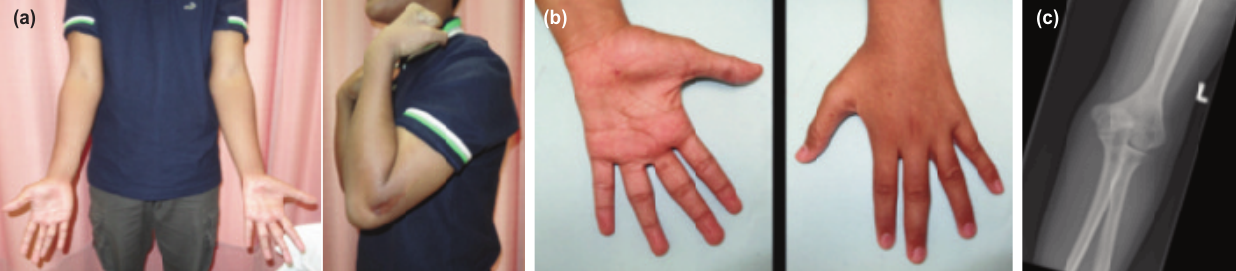
Clinical and radiological photographs four years after surgery. (a) Left elbow deformity corrected with full range of elbow Fig. 3: movement. (b) Resolution of the claw hand deformity. (c) Radiograph showing complete healing with a fish-tail deformity of the distal